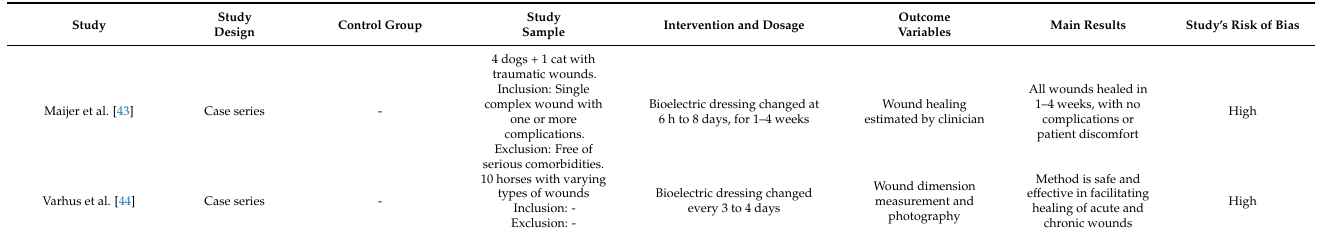
Table 8. Review of articles regarding bioelectricity.